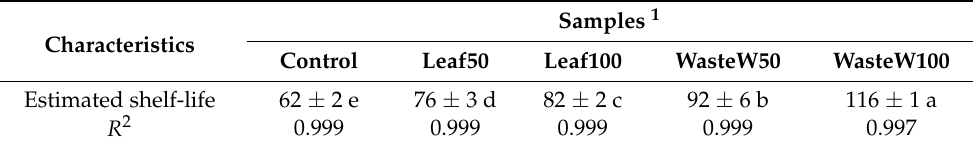
Table 5. Estimated shelf-life of GF breadsticks based on lipid oxidation data (day at 25 ◦ C).